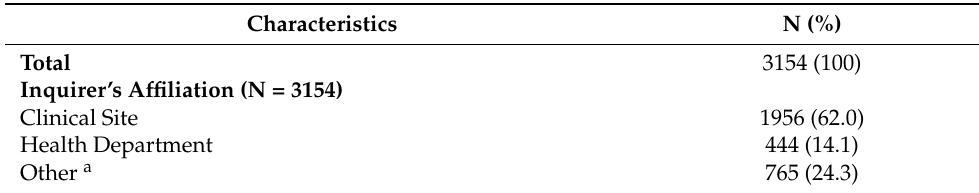
Table 1. Summary of COVID-19 related telephone inquiries for real-time consultation—United